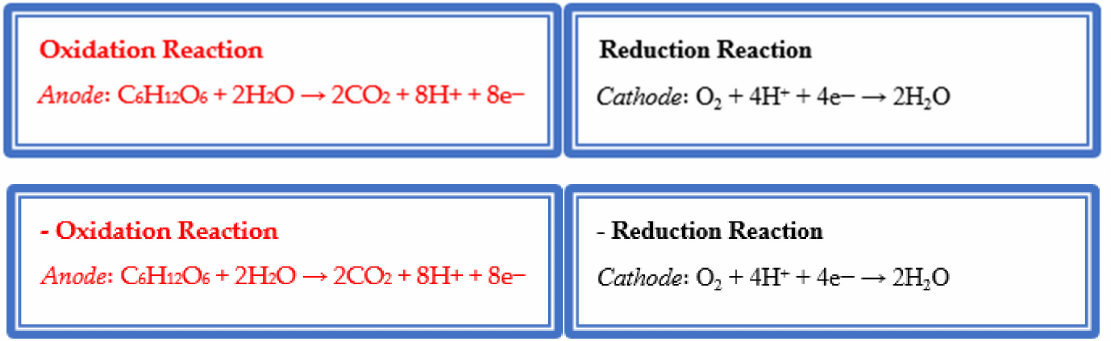
Figure 3. Oxidation and reduction reaction in their respective